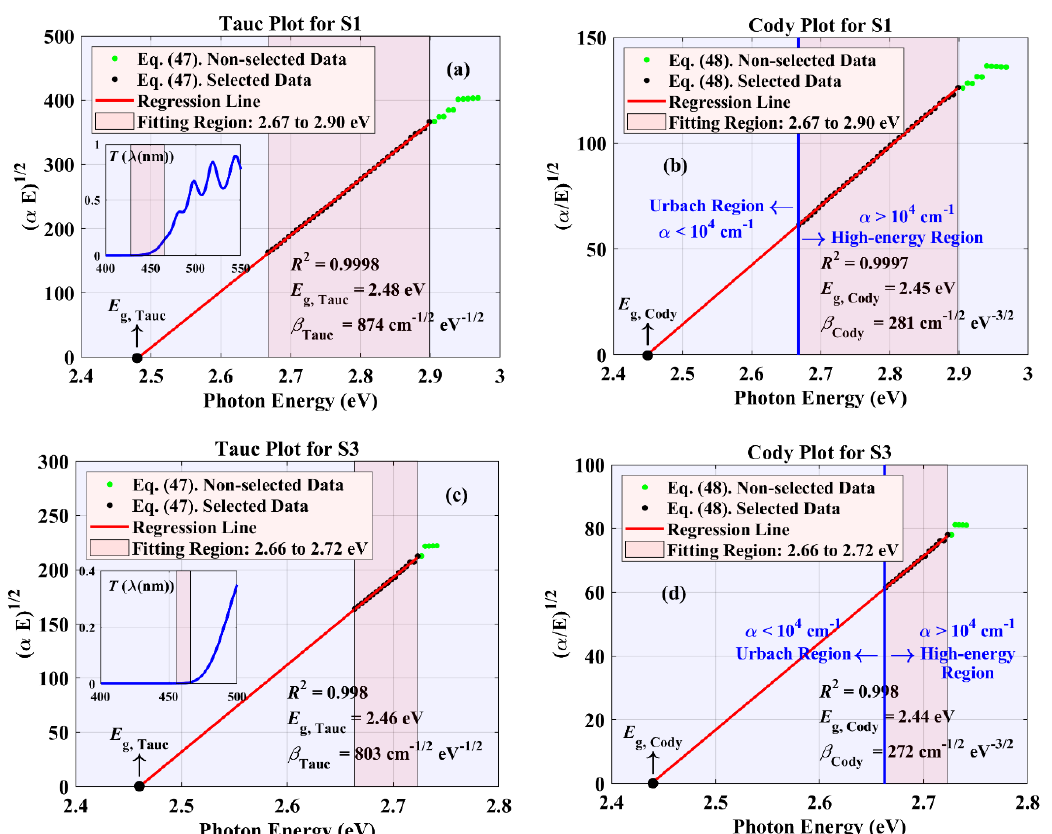
Figure 9. ( a , c ) Tauc, and ( b , d ) Cody plots obtained from the transmission spectra S1 and S3, belonging Figure 9. ( a ) and ( c ) Tauc, and ( b ) and ( d ) Cody plots obtained from the transmission spectra S1 and to the two representative chalcogenide S3, belonging to the two representative chalcogenide films.